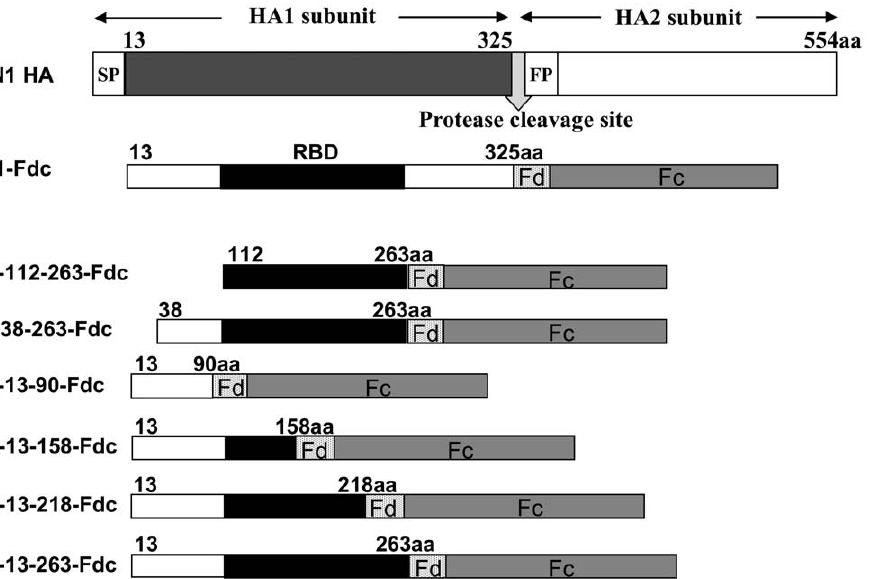
Figure 1. Construction of recombinant truncated HA1 protein fragments fused with Fd and Fc. (A) Schematic structure of HA protein of A/Anhui/1/2005 (H5N1 HA). SP, signal peptide. FP, fusion peptide. HA1-Fdc protein was previously expressed covering HA residues + 3–322 [15], corresponding to residues 13–325 of H5 numbering as described in the published literature [9,20,21]. (B) Truncated HA fragments covering various lengths of HA1 were constructed by fusing HA1 fragments with Fd and Fc. Each fragment contains IL2ss signal peptide at the 5 9 terminus for the purpose of leading expressed proteins to the culture supernatant. The predicted RBD region was indicated in black.